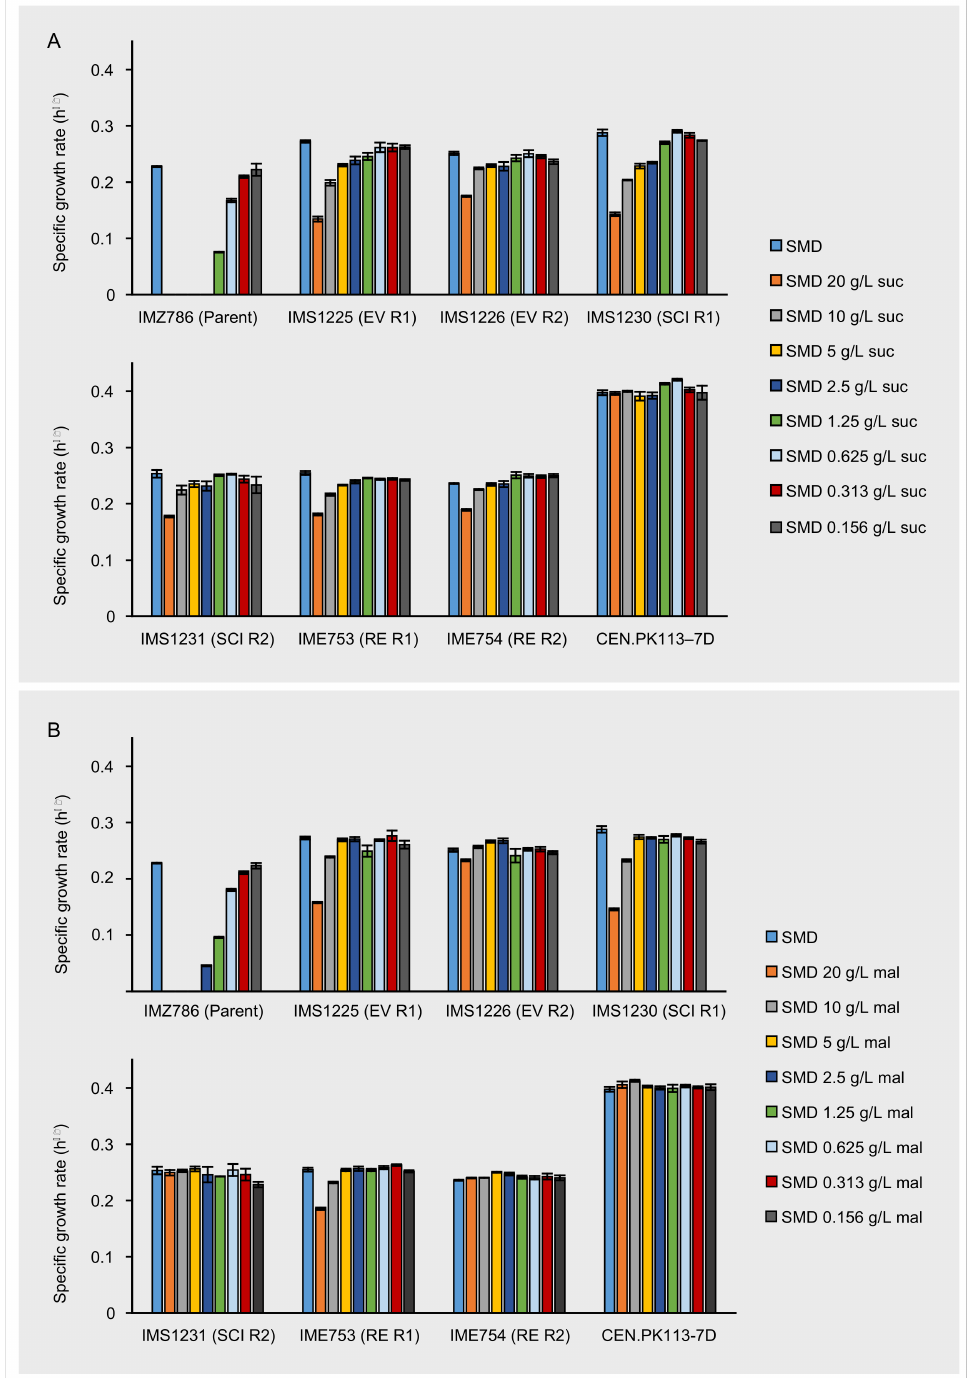
Figure 1. Maximum specific growth rates of IMZ786 ( sugar 0 MAL11 ) and strains that originate thereof, which were the evolved populations (EV) after laboratory evolution in glucose-limited continuous cultures with increasing addition of sucrose in two independent reactors (R1 and R2), the corresponding single-colony isolates (SCI) and the corresponding reverse engineered strains (RE). ( A ) Maximum specific growth rates on SMD within the presence of different concentrations of sucrose (suc). ( B ) Maximum specific growth rates on SMD with in the presence of different concentrations of maltose (mal). Data represent average and mean deviation of three replicate experiments. To validate the experimental procedure and data analysis, the growth rates of laboratory strain CEN.PK113-7D were also determined in all